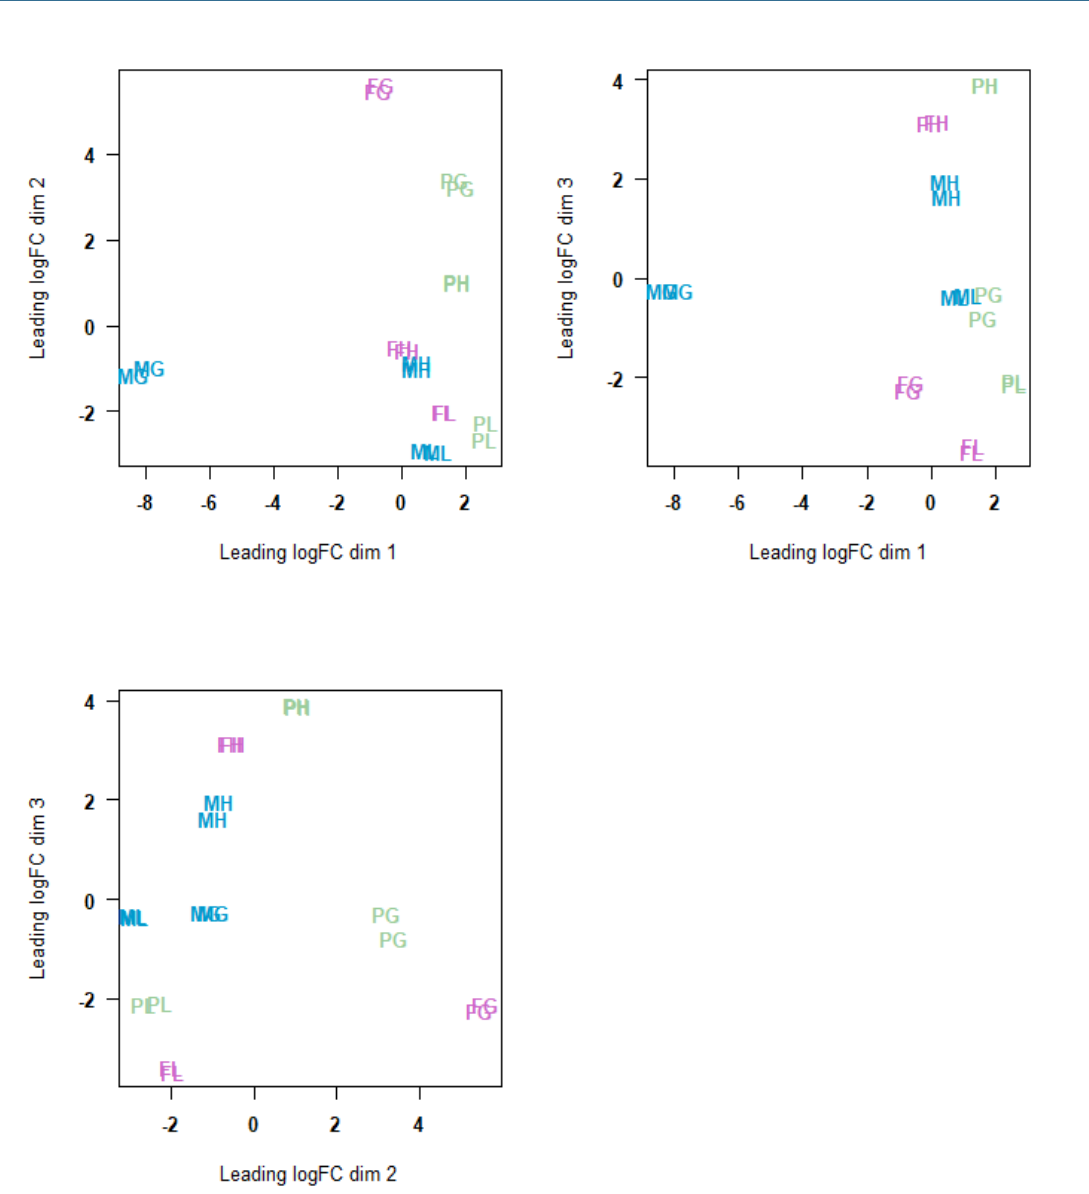
Supplementary figure S1 : Multidimensional scaling (MDS, Limma R Package) of distances between gene expression profiles of the 18 samples using the plotMDS function with default settings (top = 500, gene.selection = “pairwise” in plotMDS function). MG: Male gonads, MH: male head, ML: male leg, FG: sexual female gonad, FH: sexual female head, FL: sexual female leg, PG: parthenogenetic female gonad, PH: parthenogenetic female head, PL: parthenogenetic female leg. The first dimension separates male gonads from all other samples, the second one separates mainly the female and parthenogenetic female gonads from legs and head samples, while the third one discriminates among head and leg